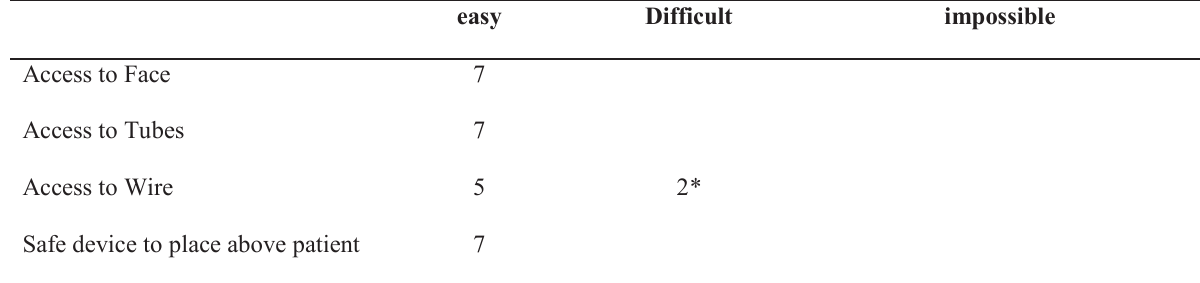
Table 6 - Anesthesiogist Access to Patient